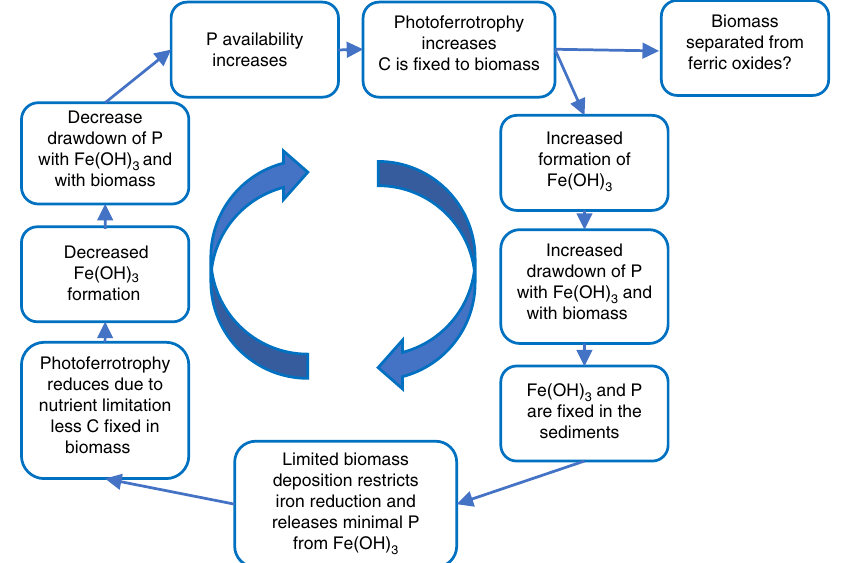
Fig. 9 Negative feedback model for BIF biogeochemical iron cycle. Minimal deposition of biomass in banded iron formations prevents phosphorus release from ferric oxides in the sediments, creating a phosphate limited growth cycle for